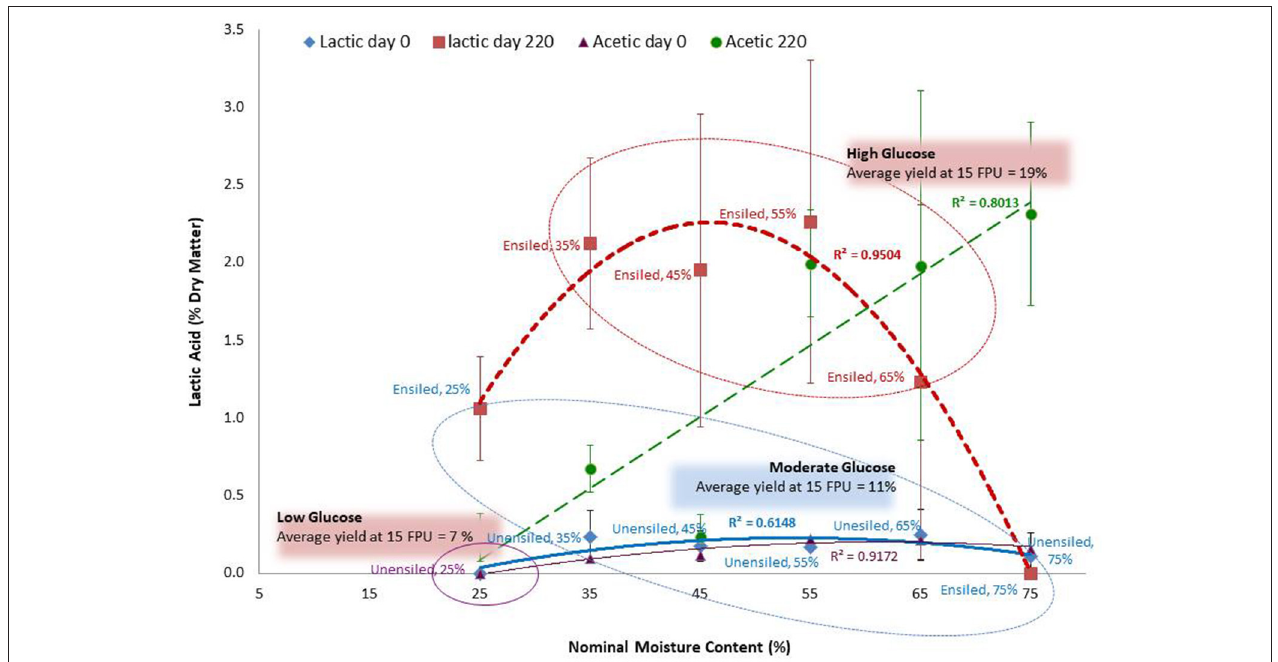
FIGURE 8 | Relating glucose from fiber reactivity grouping of PA corn stover without pretreatment with lactic acid and acetic acid. To capture a better range of amount of acid produced during silage, data for lactic and acetic acid is a wider set that includes data of corn stover feedstock not used in the fiber reactivity test (i.e., includes samples stores at 23 ◦ C). See Darku (2013b). The R-square values are for mean acid values and so do not capture the variability of organic acid yield at the various moisture levels. The three groups (captured within the ovals) show lactic acid levels and glucose yields that are not significantly different within groups but significantly different among groups. Error bars are standard deviations of